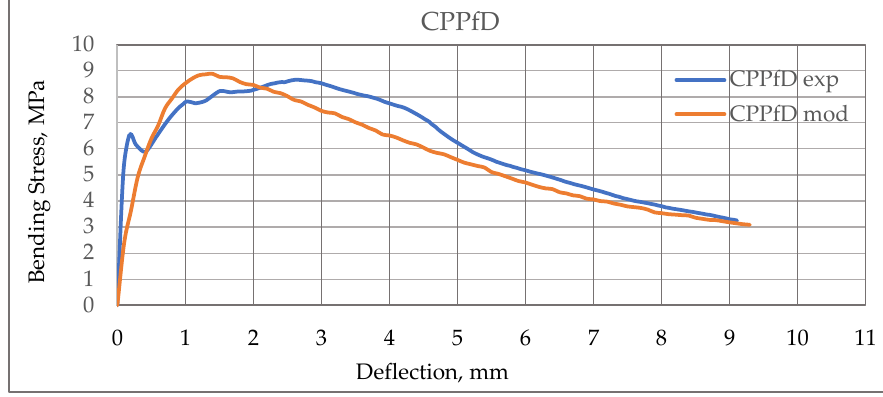
Figure 7. Experimental and modelling data comparison for the group CPPfD.